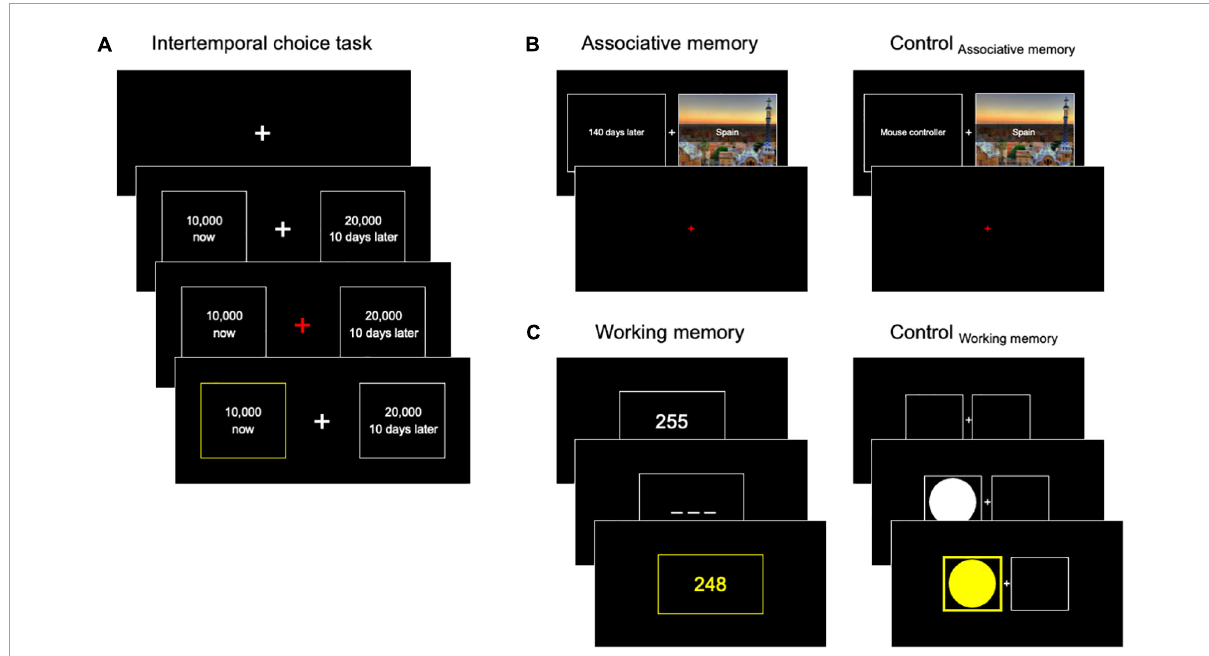
FIGURE1 Intertemporal choice task and cognitive intervention paradigms. (A) During the intertemporal choice (ITC) task, the participants made choices between an immediate smaller reward and a delayed larger reward. The immediate reward was fixed (10,000 Korean Won, KRW), but the alternative delayed option was constructed using six distinct delays (1, 10, 21, 50, 90, and 180 days) and varying sizes of delayed rewards (10, 300–29, 300 KRW) determined by stepwise approach. Individuals could make a response when the crosshair turned red, and a feedback screen followed their choices to highlight the chosen option. (B,C) Two intervention tasks and their control tasks were used to examine the impacts of associative memory and working memory on future reward simulation and, in turn, on delay discounting. ( B , left) The associative memory task comprised the encoding and retrieval phases (not depicted here). In the encoding phase, the participants were asked to memorize associations between the paired stimuli. Specifically, names of countries with a picture of their representative must-see sights were matched with “expected preparation time” to go on a trip to the places. Note that the preparation time was presented in the same format as the reward delays used in the ITC task (e.g., 10 days later). ( B , right) The Control AM was largely identical to the Associative memory task, except that the associations were made between country names and various stationaries. ( C , left) In the working memory task, the participants had to remember a random three-digit number presented on the screen (e.g., 255), mentally subtract seven, and report the number on the subsequent screen (e.g., 248). They were asked to repeat this mental calculation (e.g., 241, 234, 237, ... ) until a new random number was provided. ( C , right) During the